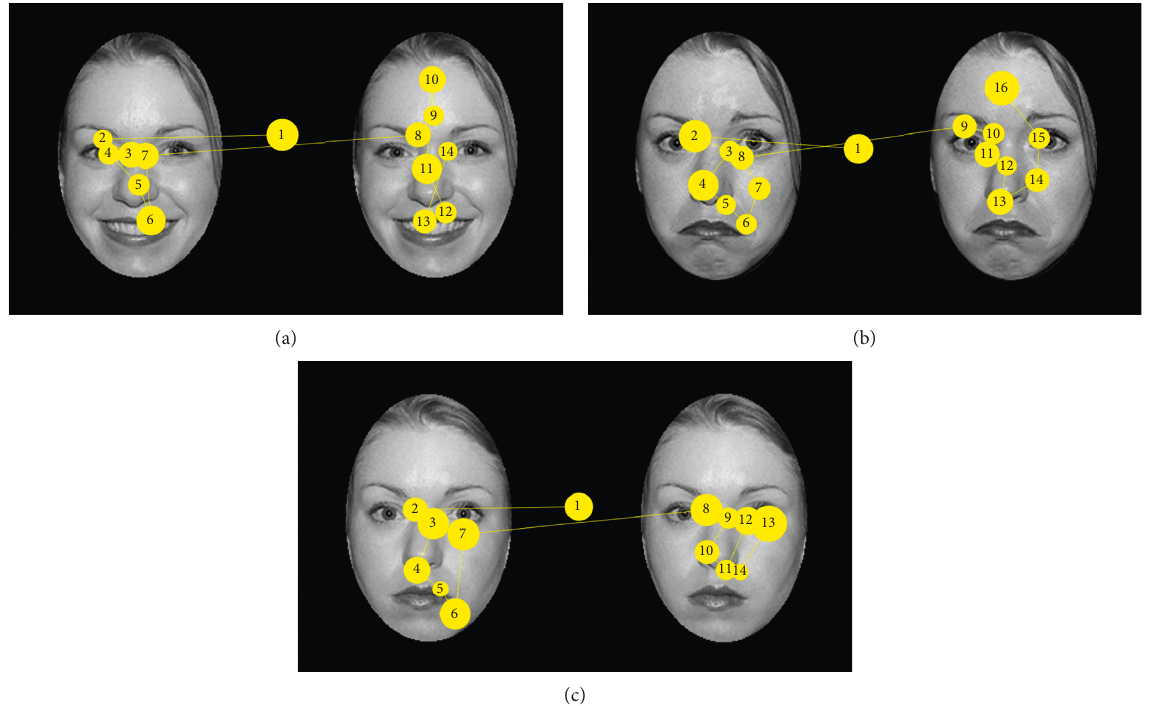
Figure 2: An example of eye movements when a depressed patient views (a) positive task, (b) negative task, and (c) neutral task. Each circle represents a gaze point, and its size represents the length of fixation